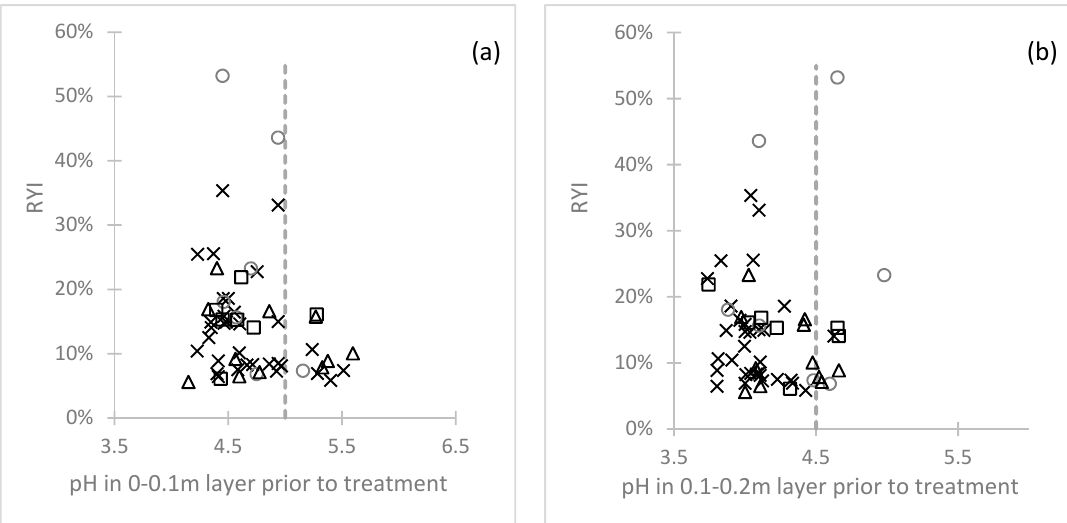
Figure 5. Relationship between relative yield increase and pH in 0–0.1 m ( a ) and 0.1–0.2 m ( b ) for trials in WA, NSW and VIC with wheat (X), barley ( ) canola ( (cid:3) ), lupin ( ∆ ), and when cases were responsive to lime (RYI > 0.05). Dotted lined (cid:35) indicates the pH cut-off values of pH 5 in the 0–0.1 m layers and pH 4.5 in the 0.1–0.2 m